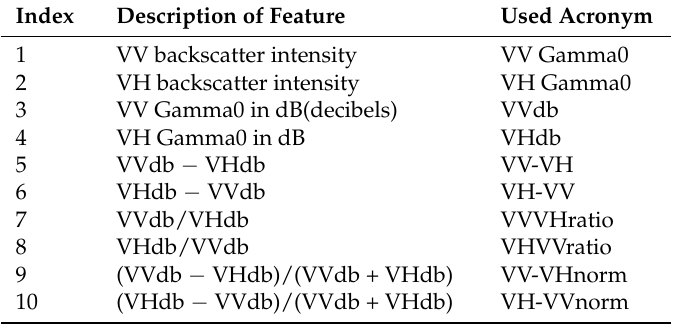
Table 3. Gamma0 backscatter features used to assess backscatter sensitivity to canopy